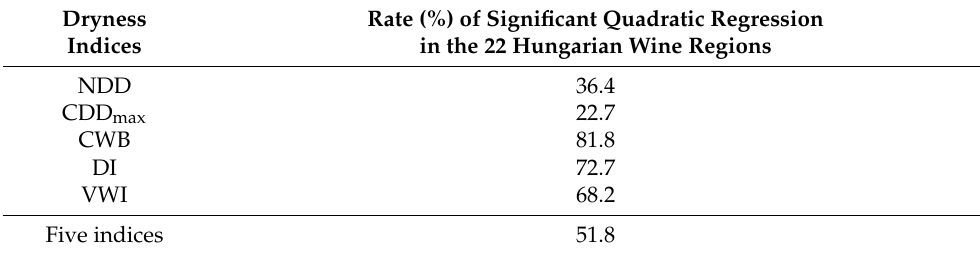
Table 5. Rates of significant quadratic regression in the 22 Hungarian wine regions (%), 2005–2021.